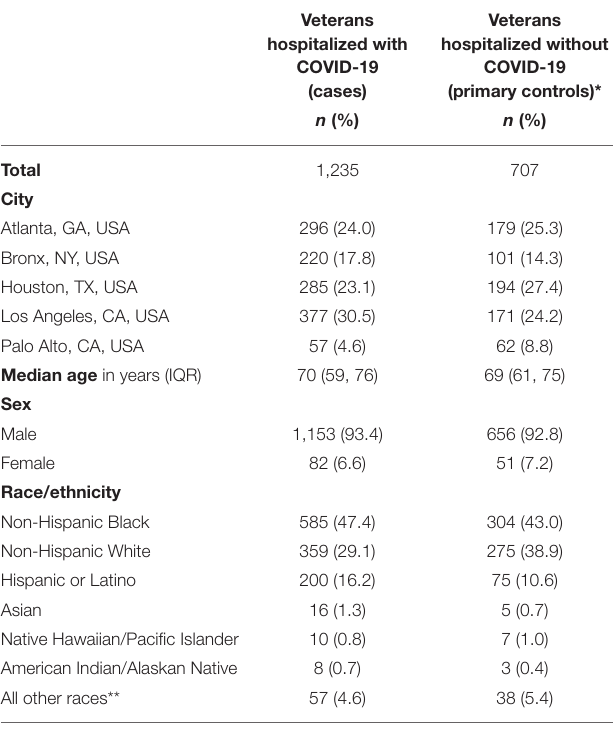
TABLE 2 | Characteristics of Veterans hospitalized with and without COVID-19—Surveillance Platform for Enteric and Respiratory Infectious Organisms at Veterans Affairs Medical Centers (SUPERNOVA), February–December